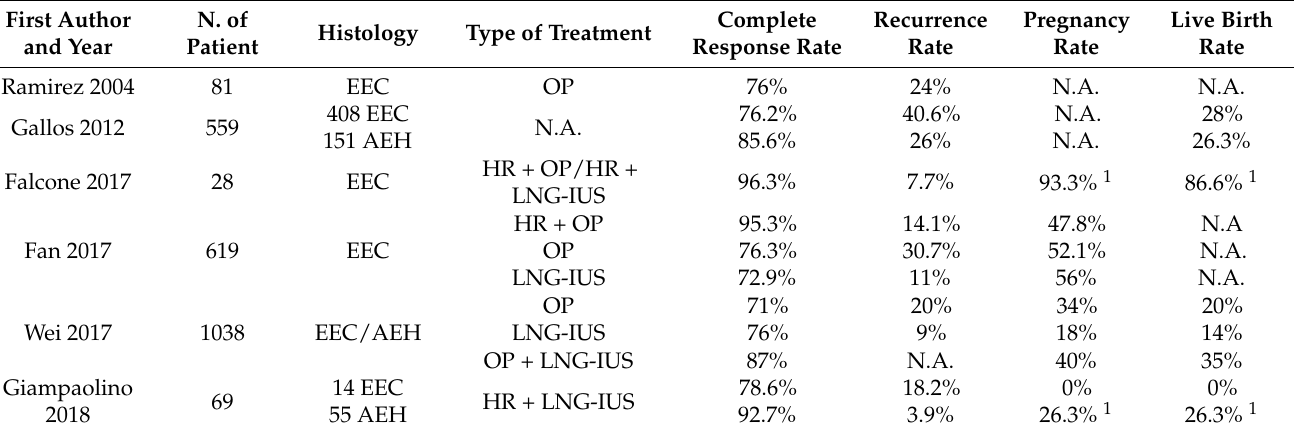
Table 1. Oncological and Reproductive outcomes of fertility-sparing treatment of endometrial